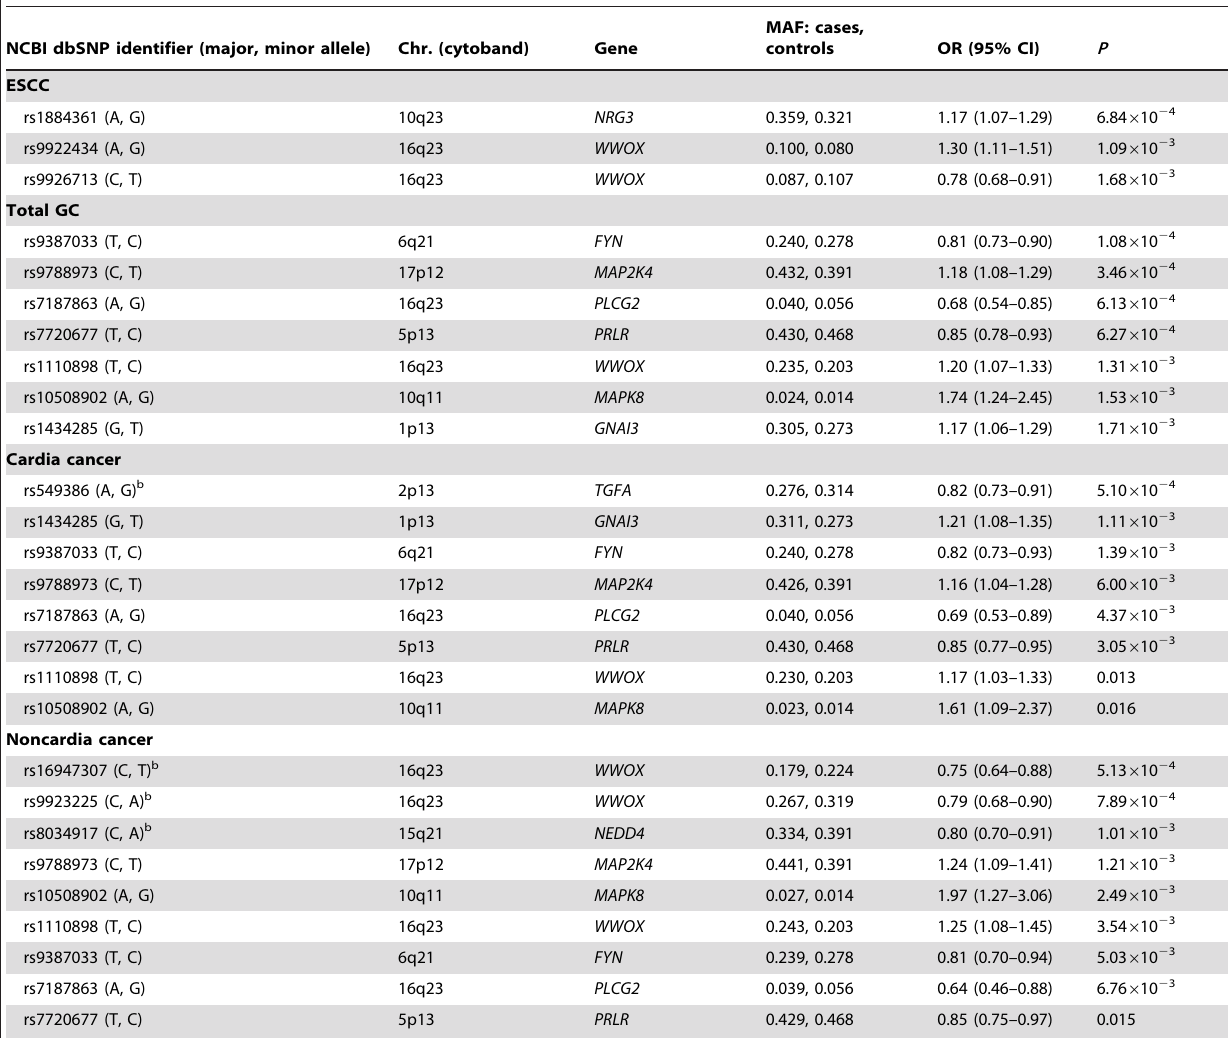
Table 3. Top SNPs associated with risk of esophageal squamous cell carcinoma (ESCC) and gastric cancer (GC) a